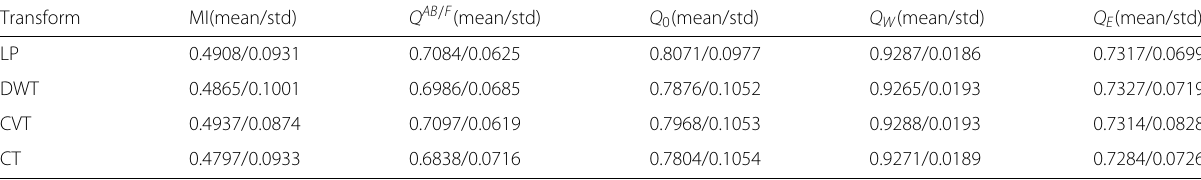
Table 3 Fusion results for multi-focus image pairs: LP, DWT, CVT Transform